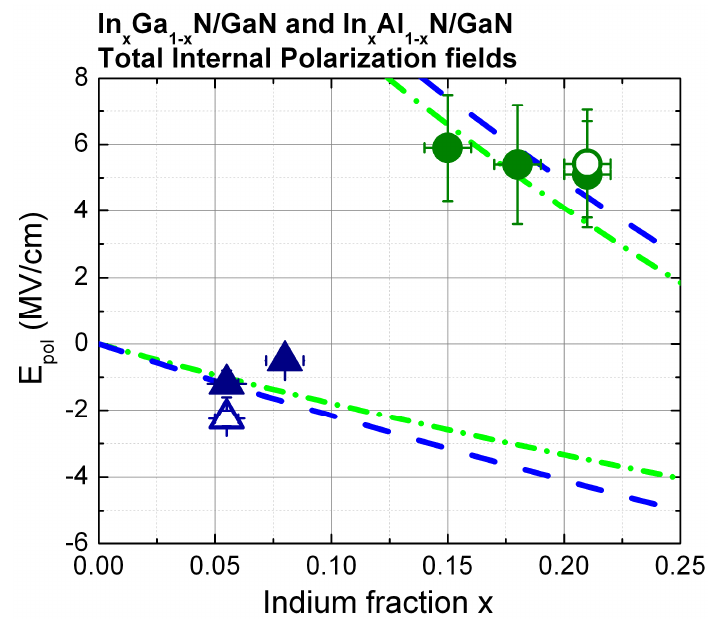
Figure 9. Comparison of the polarization field values E pol of In 0.055 Ga 0.945 N DHS (open triangle) and In 0.21 Al 0.79 N DHS (open circle) determined by ER in this work with the field values of In 0.055 Ga 0.945 N [44], In 0.08 Ga 0.92 N DHS [46] (full triangles) and In 0.15 Al 0.85 N, In 0.18 Al 0.82 N, In 0.21 Al 0.79 N DHS [45] (full circles) determined by CVM, and with theoretically predicted values [19,38] (dashed line) and [26] (dot-dashed line).